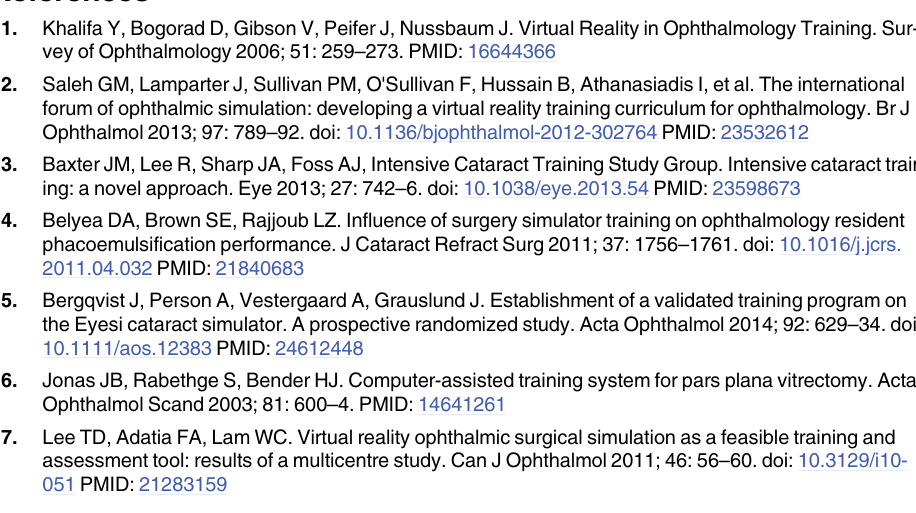
S1 Table. Scoring parameters that all simulated tasks have in common. Since the targets are task-specific, the table only shows faults and the neutral parameter “ Odometer ” that measures the travelled distance of the instruments tips. This parameter is needed for an analysis of the surgeons ’ instrument speed. S2 Table. Specific scoring parameters for simulated ILM peeling. The primary target is marked with a star ( (cid:1) ). S3 Table. Specific scoring parameters for simulated retinal detachment surgery. Target parameters are indicated by a positive, faults by a negative point range. The primary targets are marked with a star ( (cid:1)